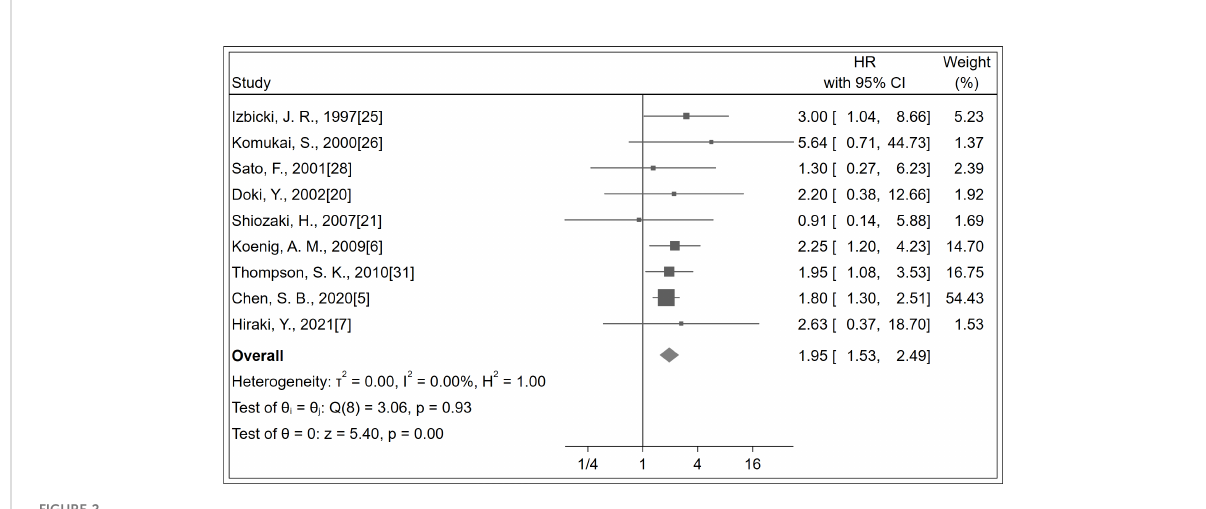
FIGURE 2 Forest plot of OS.